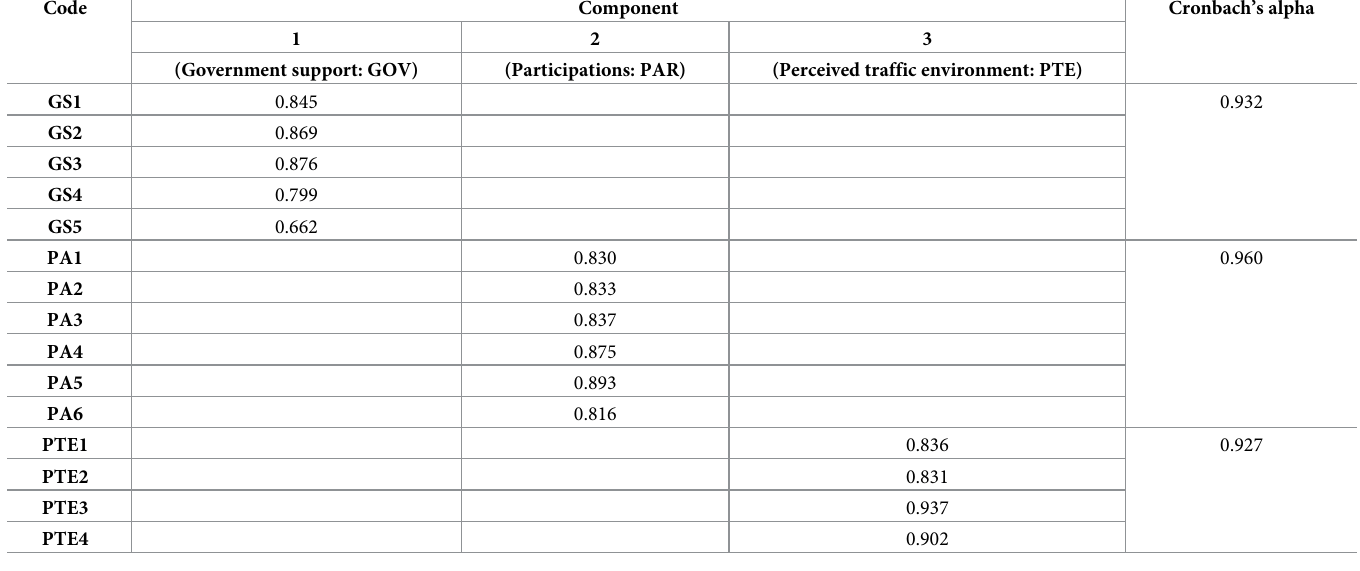
Table 4. Road safety policy results of EFA; KMO = 0.864.